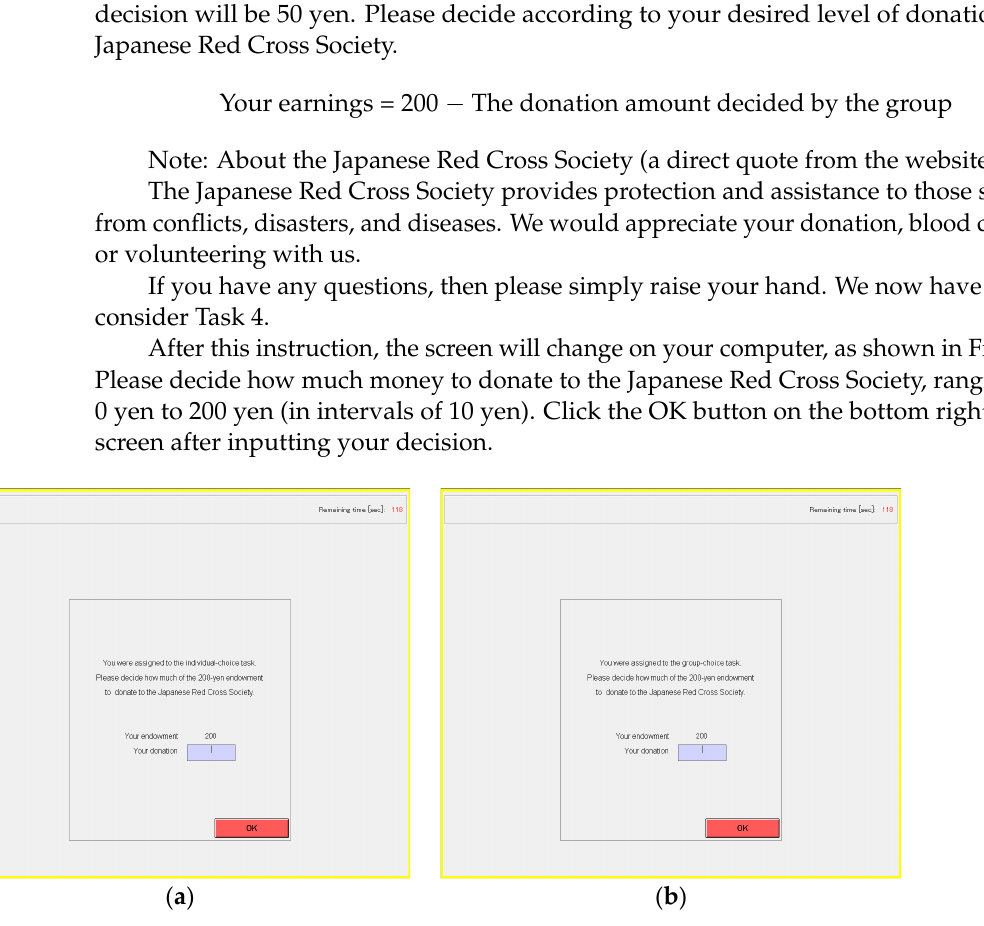
Figure A5. Computer screen for Task 4: ( a ) For individual-choice task; ( b ) For group-choice task.